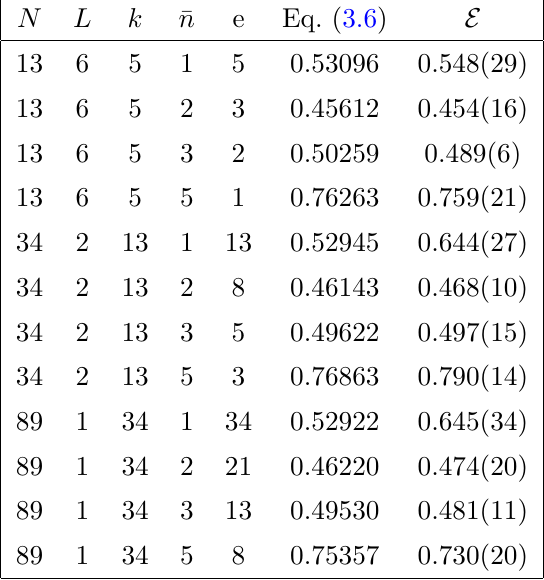
Table 2. Torelon energies for various values of N and k belonging to the Fibonacci sequence. We show the values obtained in non-perturbative lattice simulations compared with the expectations from eq.